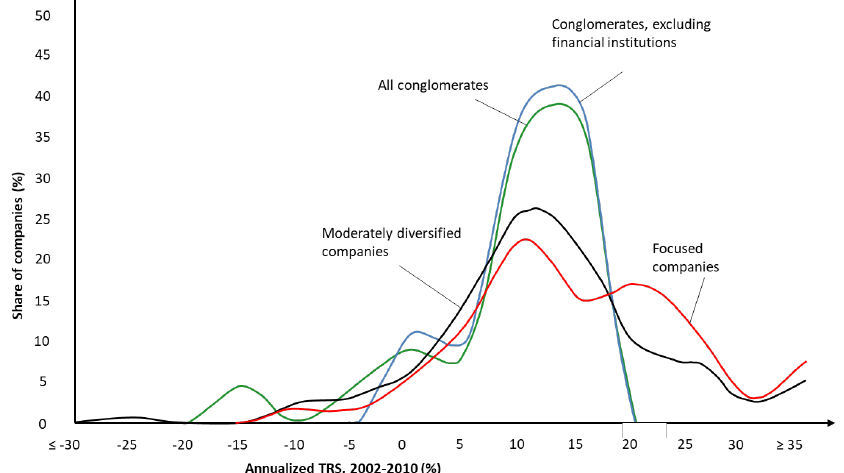
Figure 3. Distribution of total return for shareholders (TRS) for conglomerates, moderately diversified companies, and focused companies. Based on [12] (p. 3), adapted.